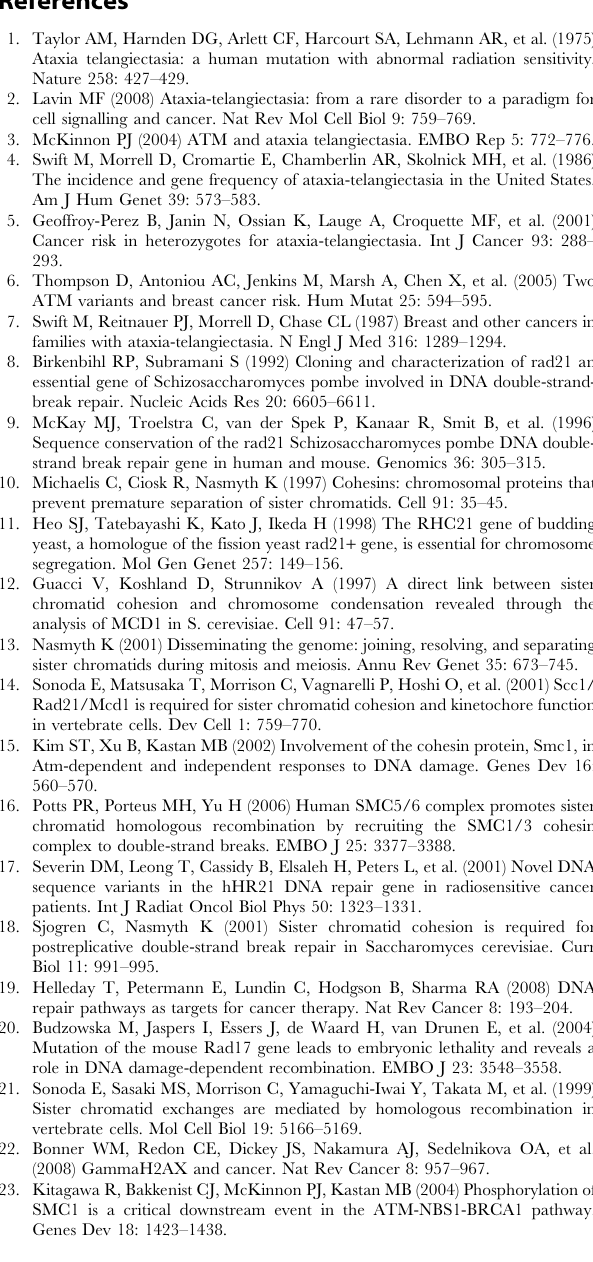
with DAPI. Focus numbers in Rad21 + / 2 cells are approximately 30 to 50 fold the number seen basally in these cells. Left panels: black and white micrographs showing c H2AX foci. Right panels: merged images of c H2AX foci (red) and DAPI (blue). Scale bars =20 m m.